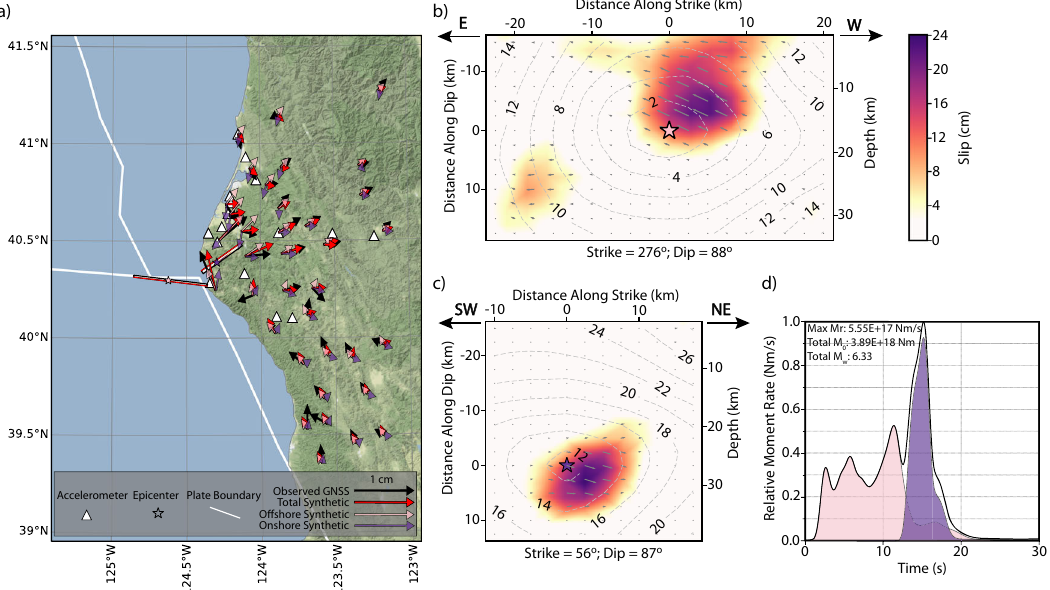
Fig. 3 Kinematic fault rupture model of the combined events. Finite fault modeling results. a Map of study area with stars denoting the slip initiation locations of both ruptures along the fault planes for each (red line indicates updip edge). Locations of strong-motion accelerometers are given as white triangles, observed static GNSS offsets are shown as black arrows with total model fi ts in red. Pink and purple arrows denote the model contributions from the offshore and onshore faults, respectively. b Slip on offshore fault and c slip on onshore fault. Stars in b , c indicates the slip initiation point with rupture front contours shown at 2 s intervals. Gray arrows indicate rake direction and are scaled by magnitude of slip. Color bar applies to both b , c . d Moment rate function for the combination of both events (black), with moment rate for offshore earthquake shaded in pink and onshore earthquake shaded in purple. Time axis is relative to the offshore event origin